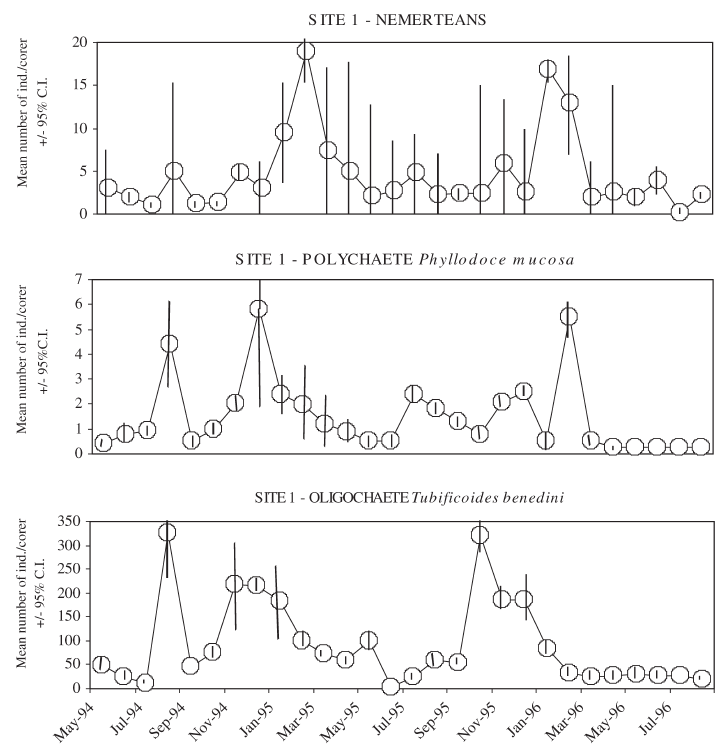
Fig . 5. – Mean abundance of some of the most conspicuous species at Site 1, Culbin Sands lagoon, NE Scotland during 1994-1996 (confidence intervals, C.I., when not fully represented, can be obtained from the symmetrical value).